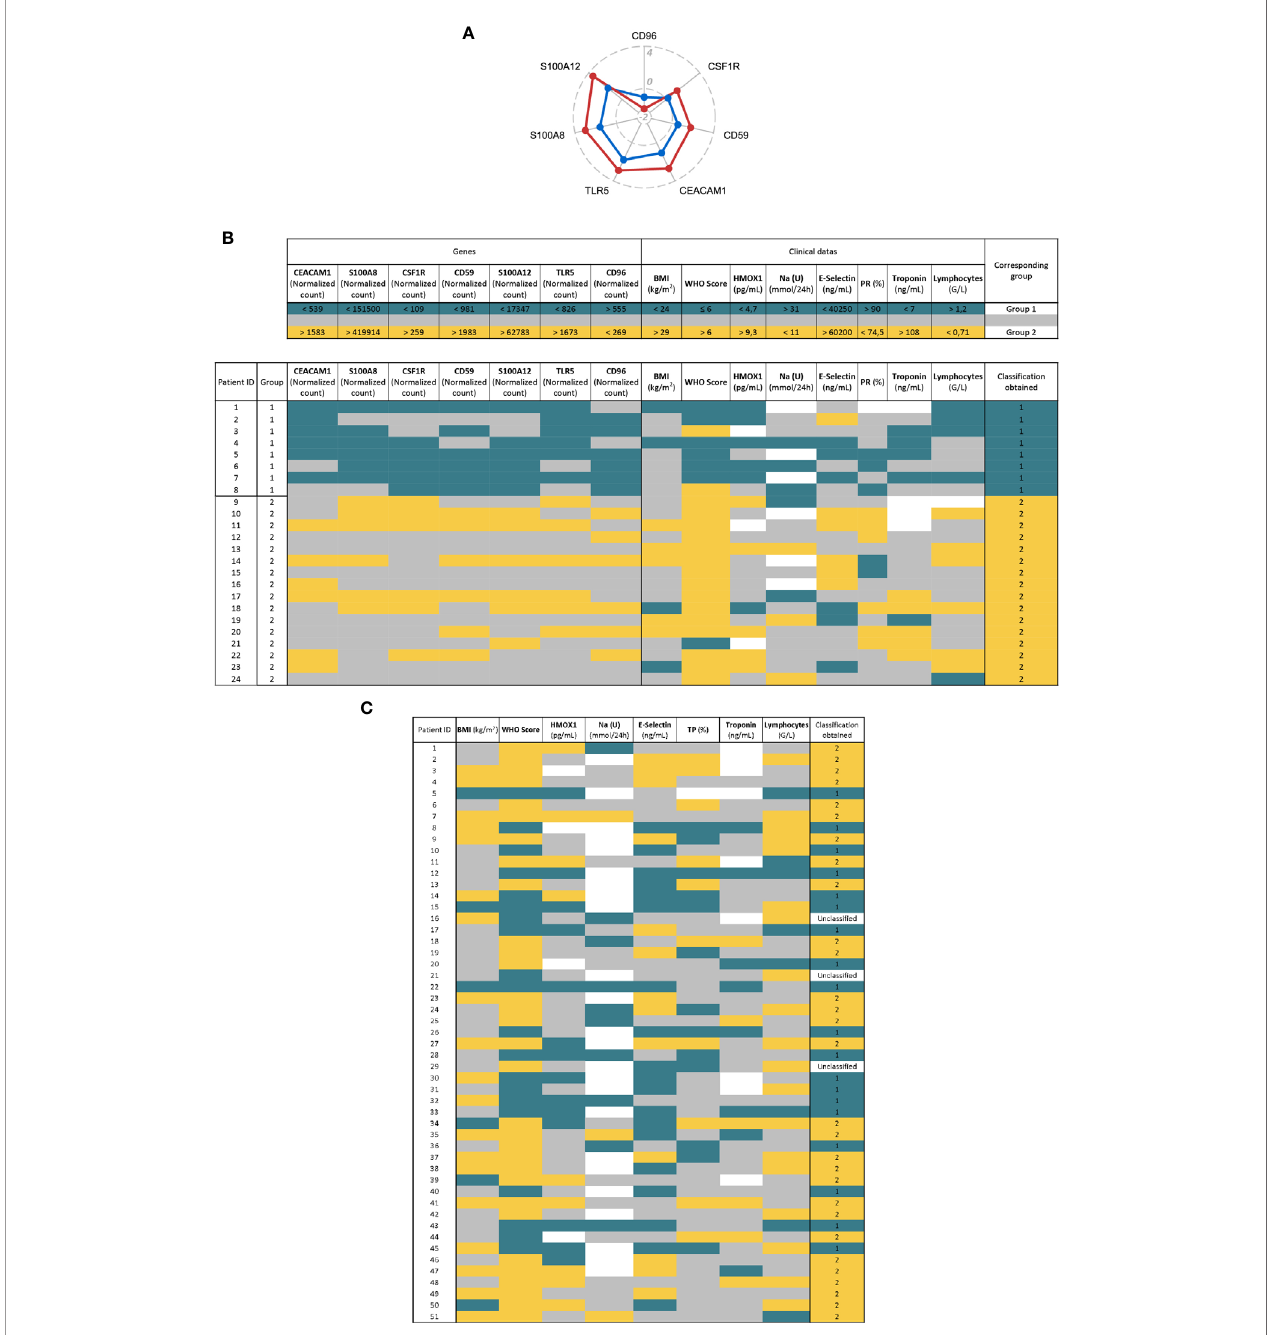
FIGURE 4 | De fi nition of a SARS-Score for hospitalized patients and proposal of therapeutic agents. (A) Radar plot showing biomarkers from the signatures. We selected the genes with less than 10% of distribution overlap between the two groups of patients. The data shown are the log2 fold change of the mean of group 1 (blue) or group 2 (red) relative to controls. (B) The SARS-Score is composed of seven genetic (left) and eight clinical variables (right). For each variable, the upper part of the table displays the thresholds de fi ned to classify patients in group 1 (blue) or 2 (yellow). These thresholds correspond to the fi rst (25%) and last quartile (75%) of the total distribution, except for the WHO score which corresponds to the threshold between mild and severe disease (WHO Score = 6). The lower part of the table shows the application of the SARS-Score on our cohort. The blue and yellow cells correspond to values allowing a classi fi cation in group 1 or 2, respectively. Gray cells represent values that do not allow classi fi cation and white cells correspond to missing values. The fi nal score (column “ classi fi cation obtained ” ) is obtained by adding up the number of each colored cell. (C) . Application of the clinical part of the SARS-Score on 51 COVID-19 patients. The color code and the thresholds used are the same as in (B) . Patients having more blue or yellow cells are classi fi ed as “ group 1 ” or “ group 2 ” , respectively. Patient having the same number of blue and yellow cells are considered as “ Unclassi fi ed ”